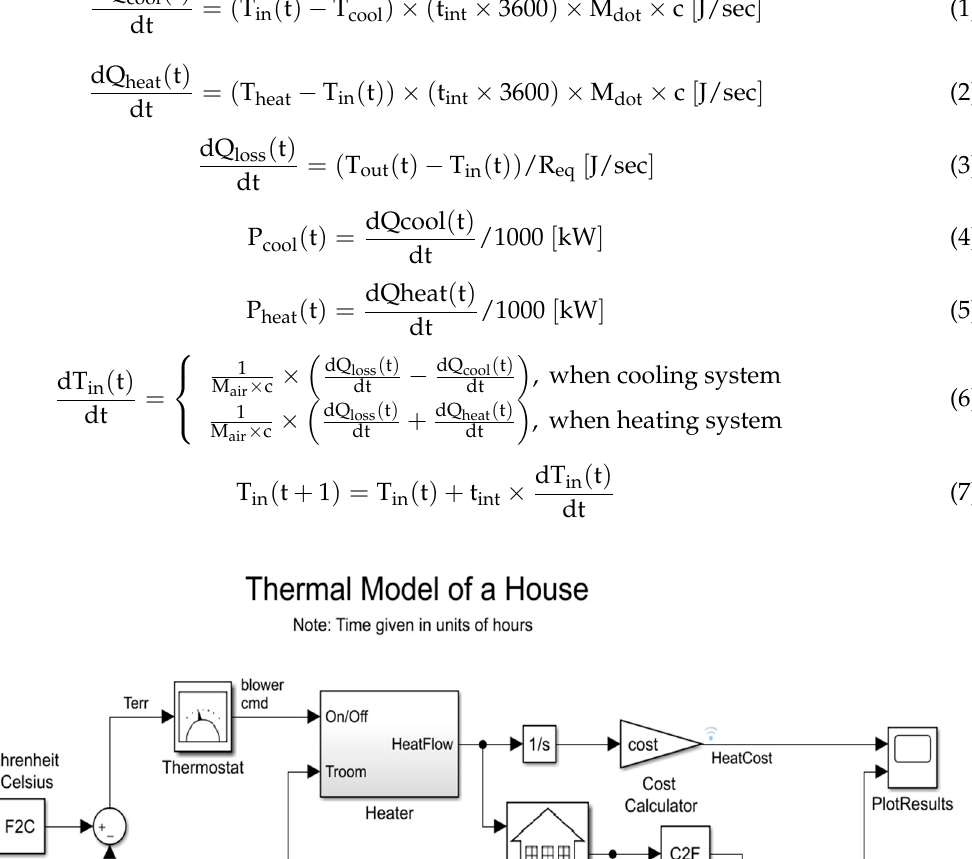
Figure 2. Seasonal comfort zone in the psychrometric chart. ( a ) 90% acceptability level; ( b ) 80% acceptability level. 2.2. HVAC System Energy Management Optimization Algorithm The objective function of the algorithm is to minimize the energy cost. The thermal model and user convenience described above are considered. The uptime of the HVAC system is regulated according to the electricity price. The HVAC system is operated at a time when the electricity price is low, thus reducing the operating number of HVAC systems at a relatively high electricity price. However, the pattern of the peak shifting is limited because the indoor temperature is continuously changed by the outdoor temperature. That is, even if the setting temperature is changed by operating at a specific time, it can only affect the next time. The objective function and the constraint conditions of the energy management optimization algorithm using the HVAC system are as follows.      